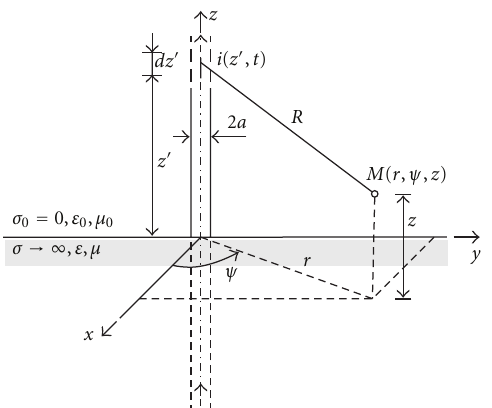
Figure 3: Model of a lightning channel at the perfectly conducting